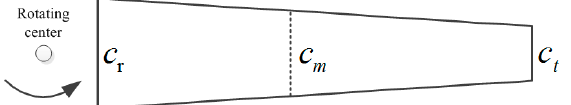
Figure 7. Coaxial trim in BEMT modeling ( C T is the total thrust coe ffi cient).